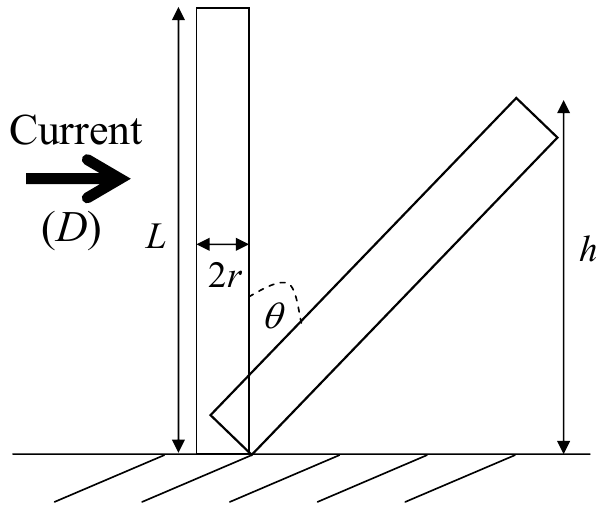
Fig. 8. Free body diagram of a decapitated Penicillus capitatus alga modeled as a cantilever beam stressed by a unidirectional current. Stress ( σ ) is calculated as 4 Dh/ ( πr 3 ) , where D is the current ve- locity, h is the height of the stalk and r is the radius of the stalk. Note that height ( h) decreases as a function of L cos θ , where L is the length of the stalk and θ is the angle of stalk deflection. From Ries (2005a).